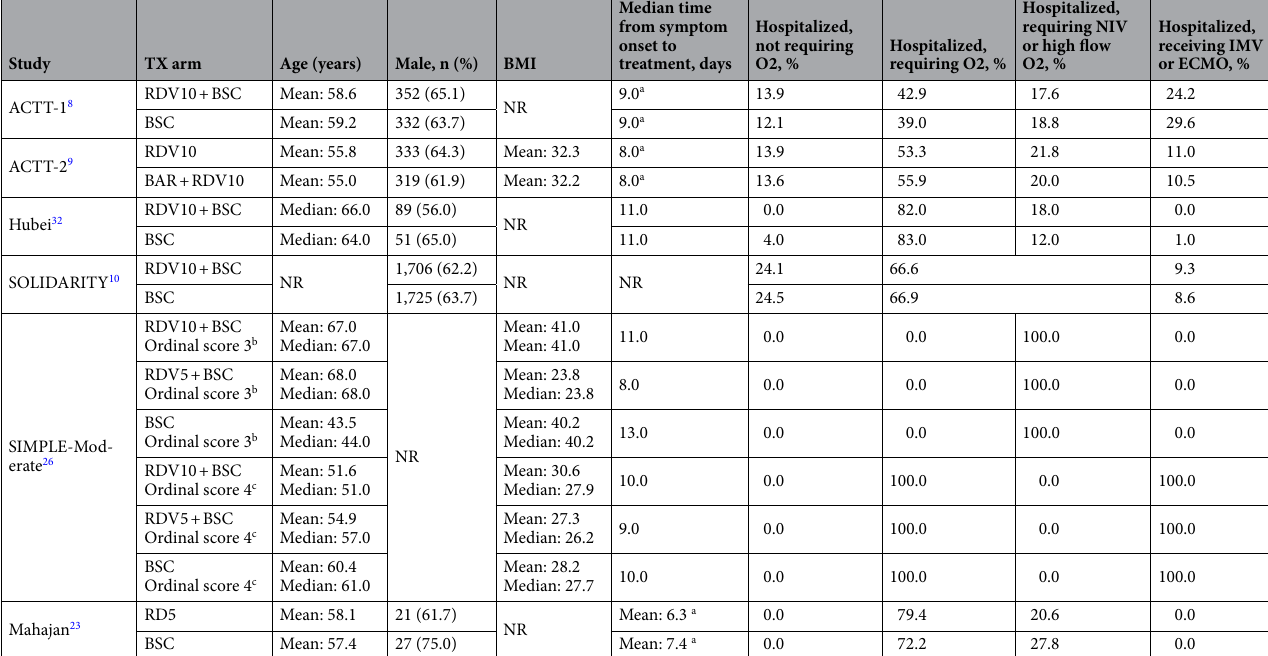
Table 2. Patient characteristics of included studies include. a Reported as time from symptom onset to randomization. b Hospitalized, receiving non-invasive ventilation or high-flow oxygen devices. c